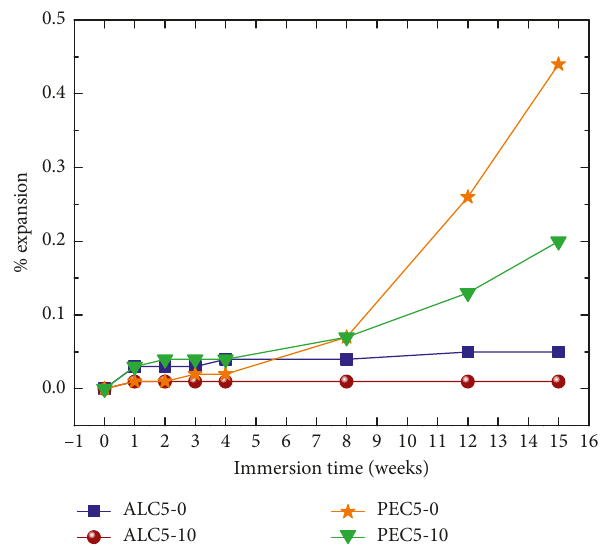
Figure 5: Length change of LWC ALC5 and PEC5 with and without addition of 10% nanosilica.